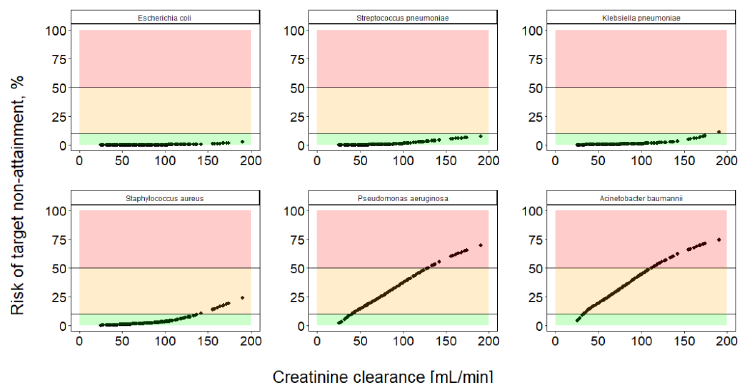
Figure 4. MeroRisk-Calculator predicted risk of target non-attainment for 6 clinically relevant pathogens. The risk of target non-attainment (unbound drug concentration 8 h after standard meropenem dosing below the minimum inhibitory concentration (MIC)) was assessed for criti- cally ill patents ( n = 155) using EUCAST MIC distributions of the investigated pathogens and cu- mulative fraction of response analysis. Risk predictions ≤ 10% (green), >10% to ≤ 50% (orange) and >50% (red) .